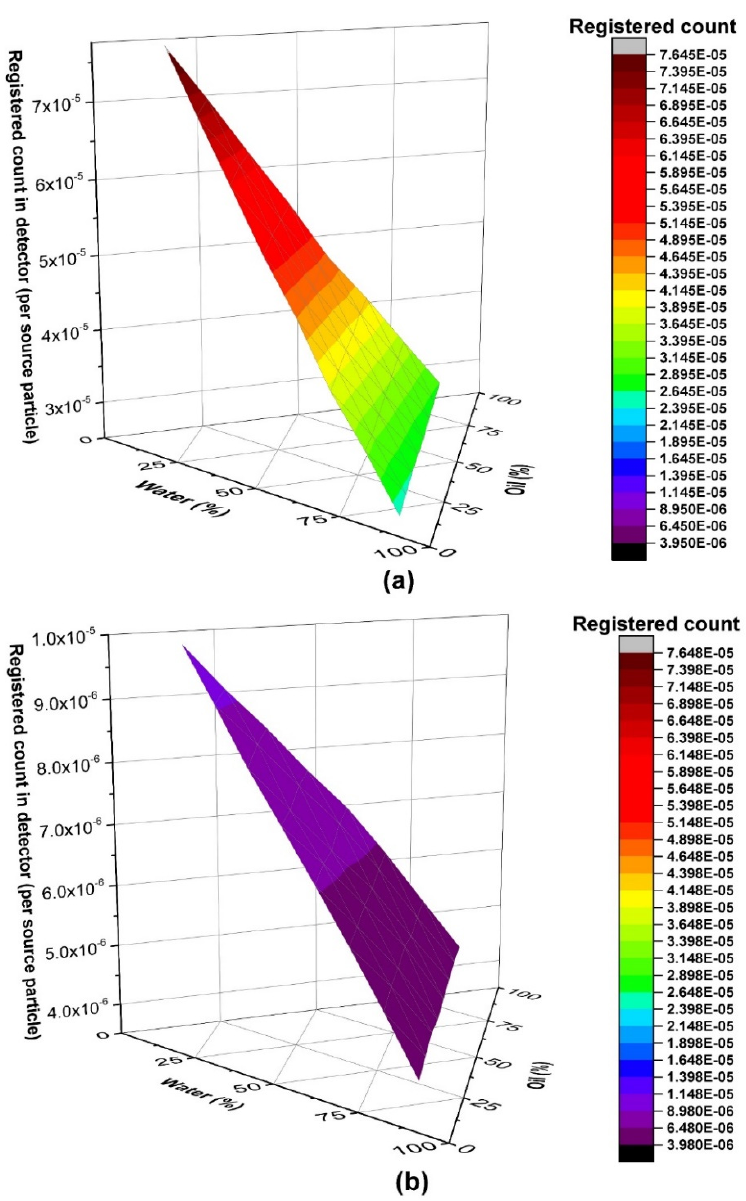
Figure 6. Recorded counts under the photopeak for the 133 Ba radioisotope in the 1st detector for various combinations of volume fractions when the scale thickness is: ( a ) 0 cm, ( b ) 2 cm.